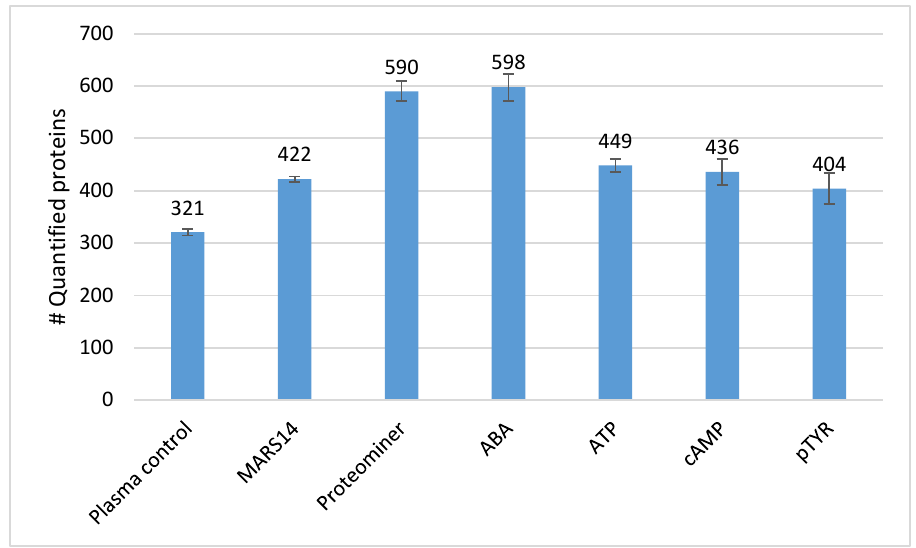
Figure 1. Number of proteins identified by the immunodepletion methods, the protein equalization method, and the affinity-based purification methods using nano-liquid high performance chromatography combined with tandem mass spectrometry (LC-MSMS) analysis. Data are mean values of six replicate experiments and the error bars indicate standard deviation.